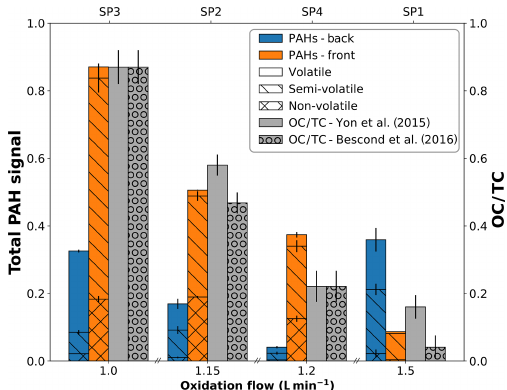
Figure 4. Variation in total PAH signal detected with L2MS at λ i = 266nm on front (orange) and back (blue) filters plotted as a func- tion of oxidation air flow. The PAH contribution is divided into ad- sorbed species non-volatile ( m/z ≥ 252), semi-volatile ( m/z 176– 242), and volatile ( m/z 78–166) fractions. OC / TC values reported in the literature are plotted in grey for